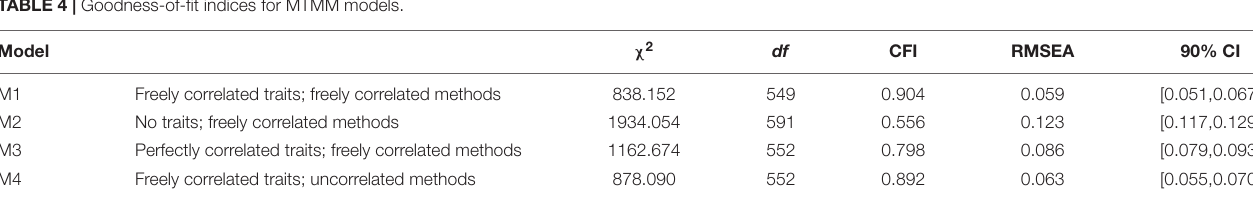
TABLE 4 | Goodness-of-fit indices for MTMM